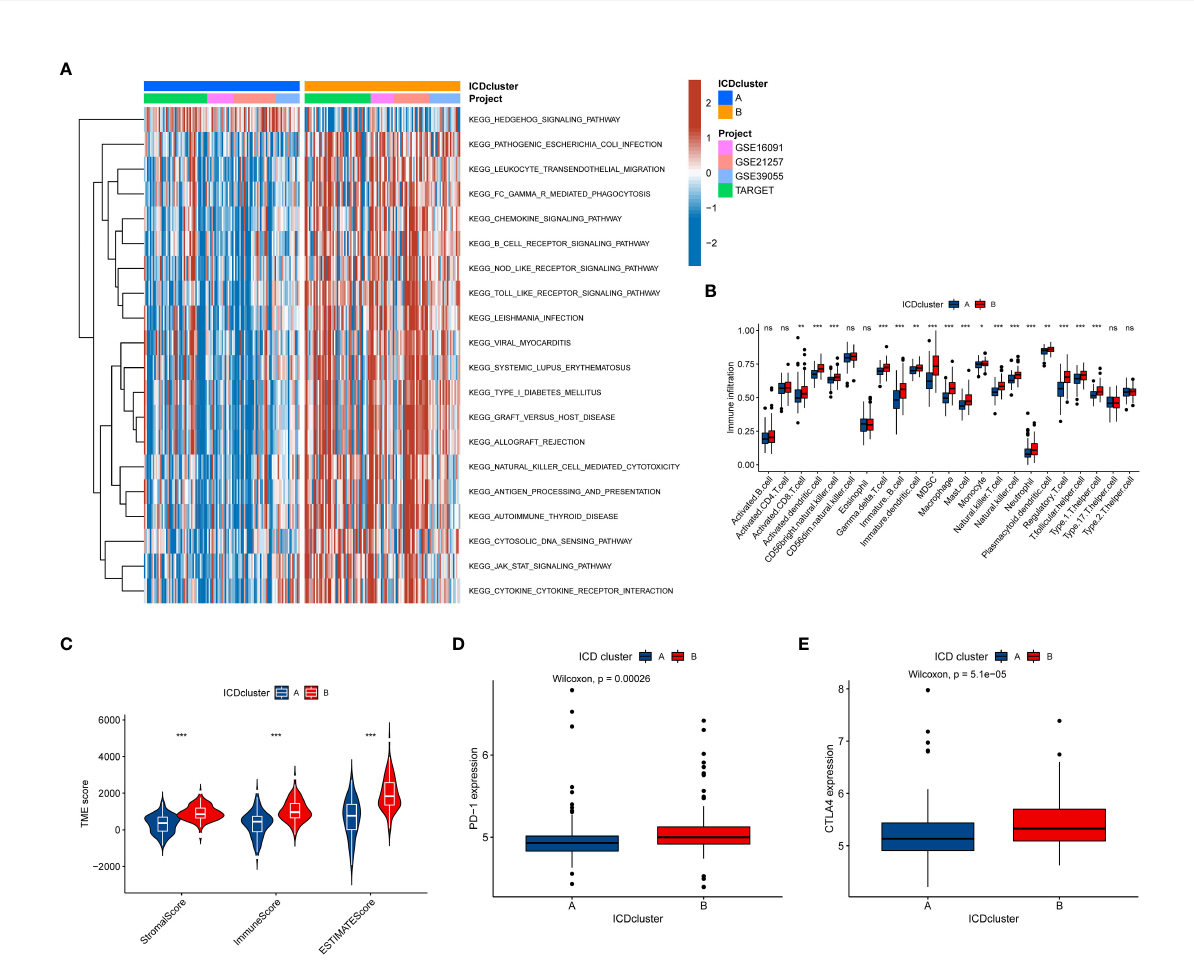
FIGURE 3 The relationship between the tumor immune cell microenvironments and ICD-related subtypes. (A) The GSVA revealed the activation status of biological pathways in two ICD-related molecular subtypes. Red: activation of biological pathways, blue: inhibition of biological pathways. (B) The abundance difference of in fi ltrating immune cell types in the two distinct subtypes. (C, D) The levels of expressed PD-1 and CTLA4 in two ICD-related subtypes. (e) The correlation between the TME score and the ICD-related subtype. ICD, Immunogenic cell death, GSVA, Gene set variation analysis, TME, tumor microenvironment. ns, no signi fi cance,*p < 0.05, **p < 0.01, ***p <